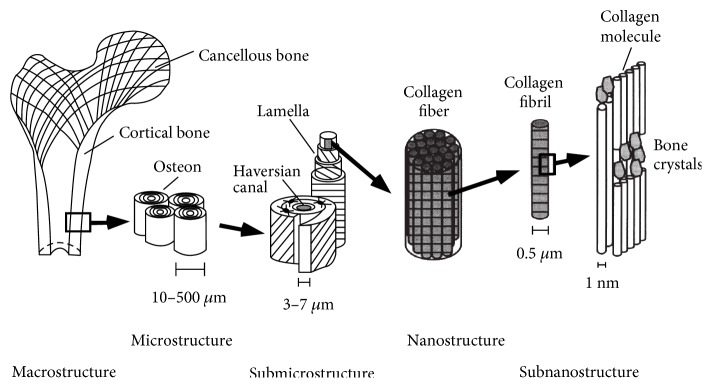
Hierarchal structure of the bone [2].